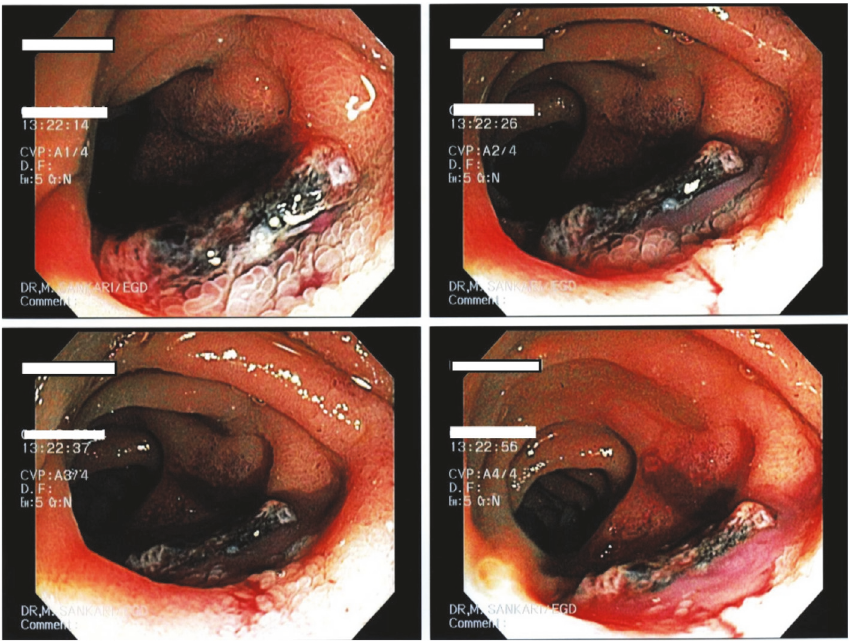
Figure 3: Push enteroscopy showing infected graft with purulent exudate extruding from an aortoduodenal